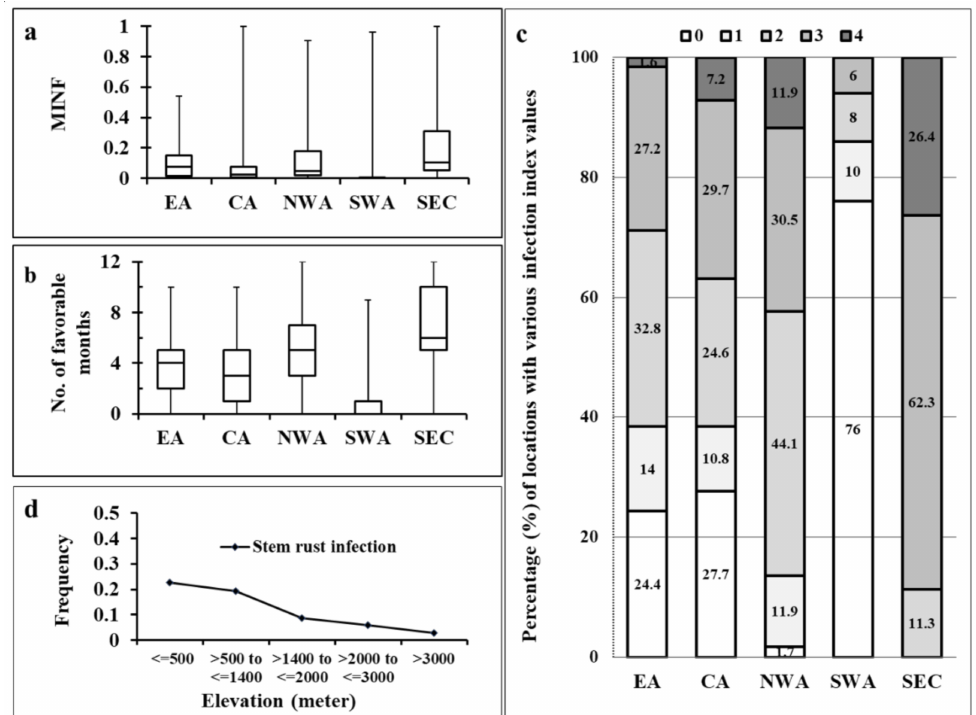
Figure 2. Normalized monthly infection index (MINF), Fav-month, and environmental suitability scores for the stem rust pathogen ( Puccinia graminis f. sp. tritici ) infection on barberry in Asian and adjacent Southeastern European regions. ( a ): boxplot for the MINF values; ( b ): boxplot for the numbers of favorable months; ( c ): frequencies of locations in different elevation intervals; and ( d ): percentages of locations with suitability scores in various regions. EA = East Asia; CA = Central Asia; NWA = Northwest Asia; SWA = Southwest Asia; and SEC = Southeast European Countries. Suitability scores: 0 = no; 1 = low; 2 = moderate; 3 = high; and 4 = very